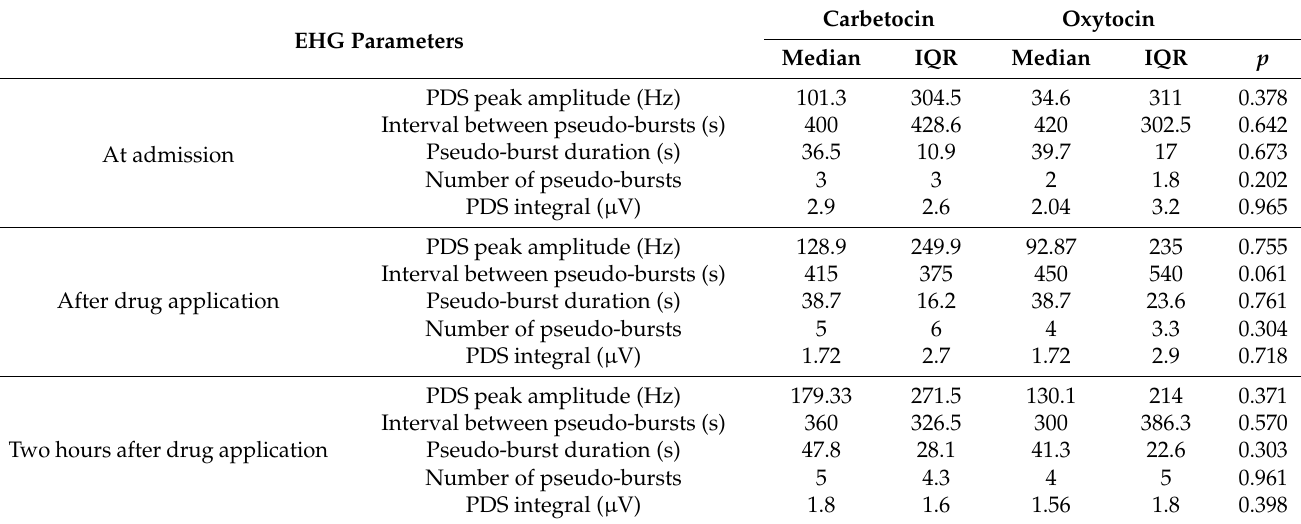
Table 2. Secondary outcome measures and electrohysterography